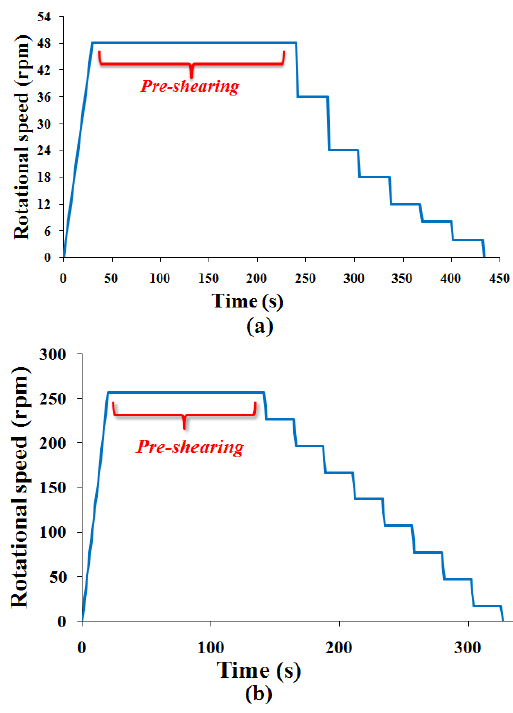
Figure 6: The profiles of the imposed rotational speed used in (a) concrete and (b) mortar rheology